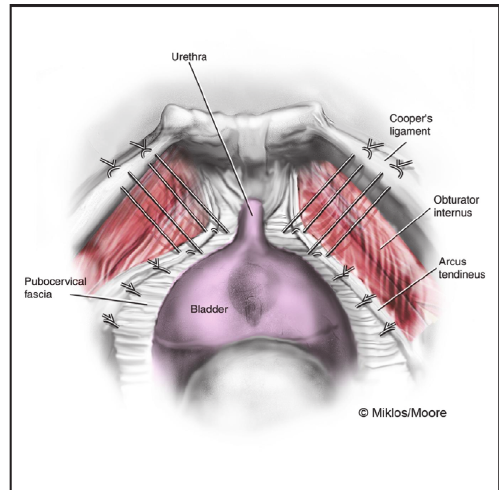
Figure 5: Illustration of Burch urethropexy and paravaginal repair. Permission to reprint from Miklos and